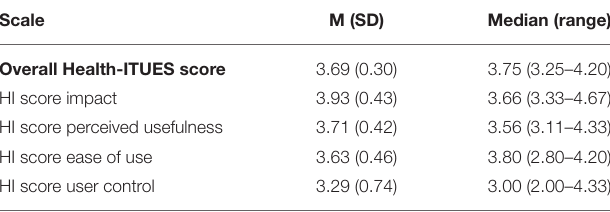
TABLE 2 | Descriptive statistics for subscales of the Health ITUES subscales. Scale M (SD) Median (range) Overall Health-ITUES